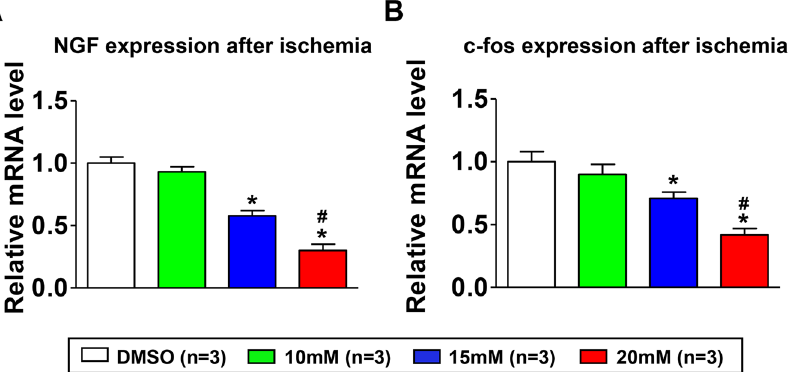
Figure 5. Effect of Nav1.8 channel block on the mRNA expression of NGF ( A ) and c-fos ( B ) in LSG. NGF = nerve growth factor. * p < 0.05 vs DMSO group, # p < 0.05 vs 10 mM